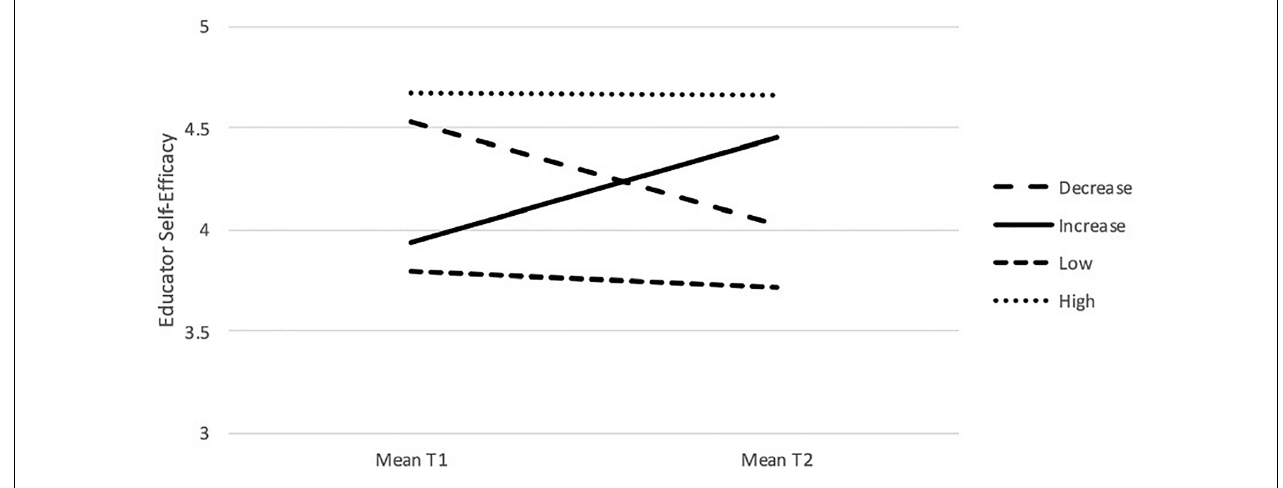
FIGURE 1 | Courses of the profiles between timepoint 1 and timepoint 2 (Means; raw scores).